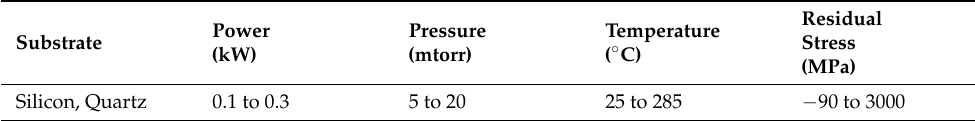
Table 16. Mechanical Material Properties of Sputter-Deposited Silicon Dioxide Material for Various Processing Conditions [133].